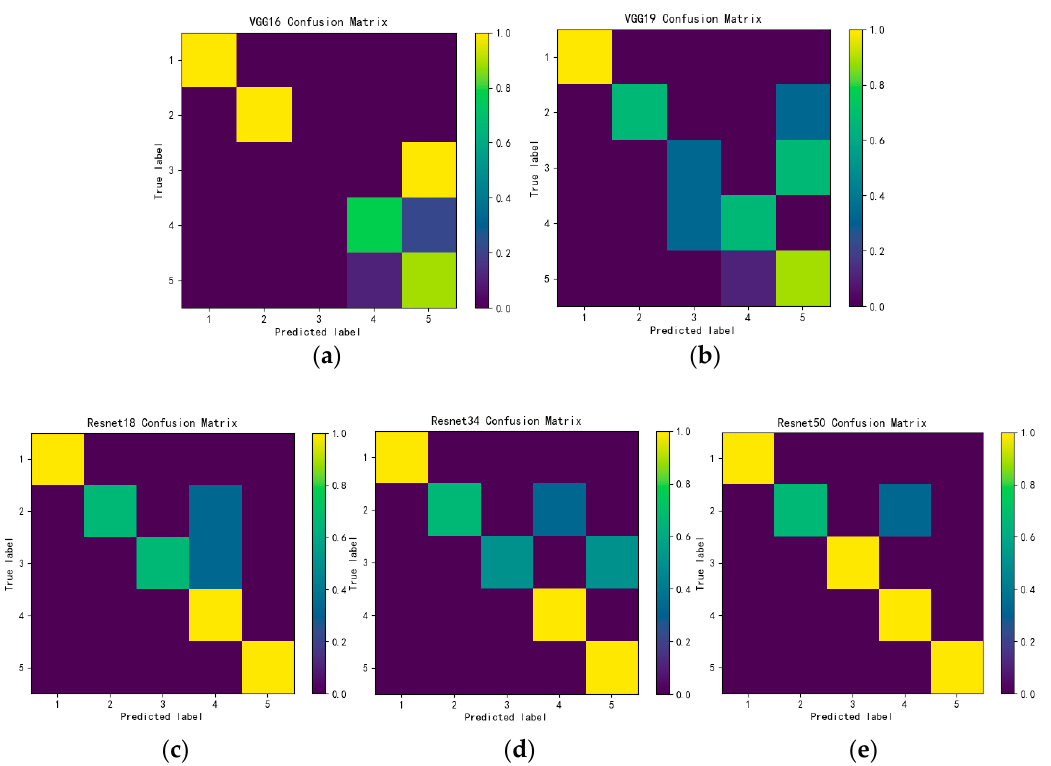
Figure 15. Confusion matrix results of five models ( a ) VGG-16; ( b ) VGG-19; ( c ) Resnet18; ( d ) Resnet34; ( e ) Resnet50.